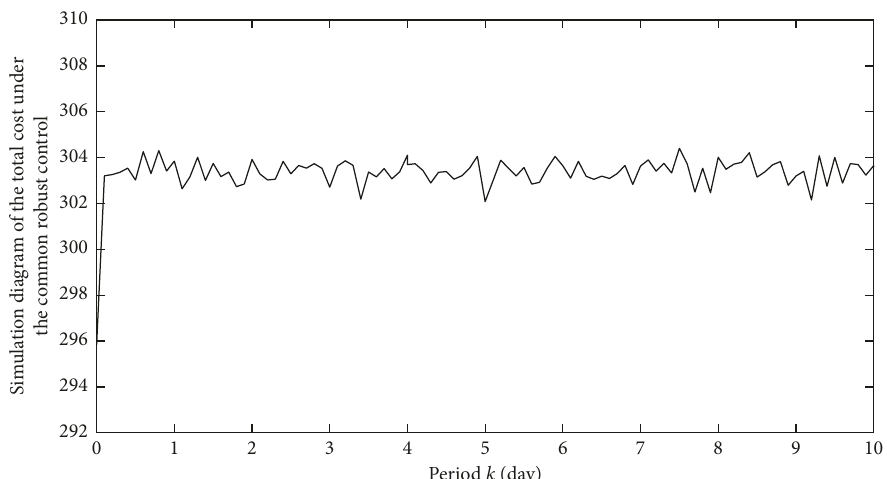
Figure 5: Simulation diagram of the total cost under CRC (unit: × 10 5 Yuan).